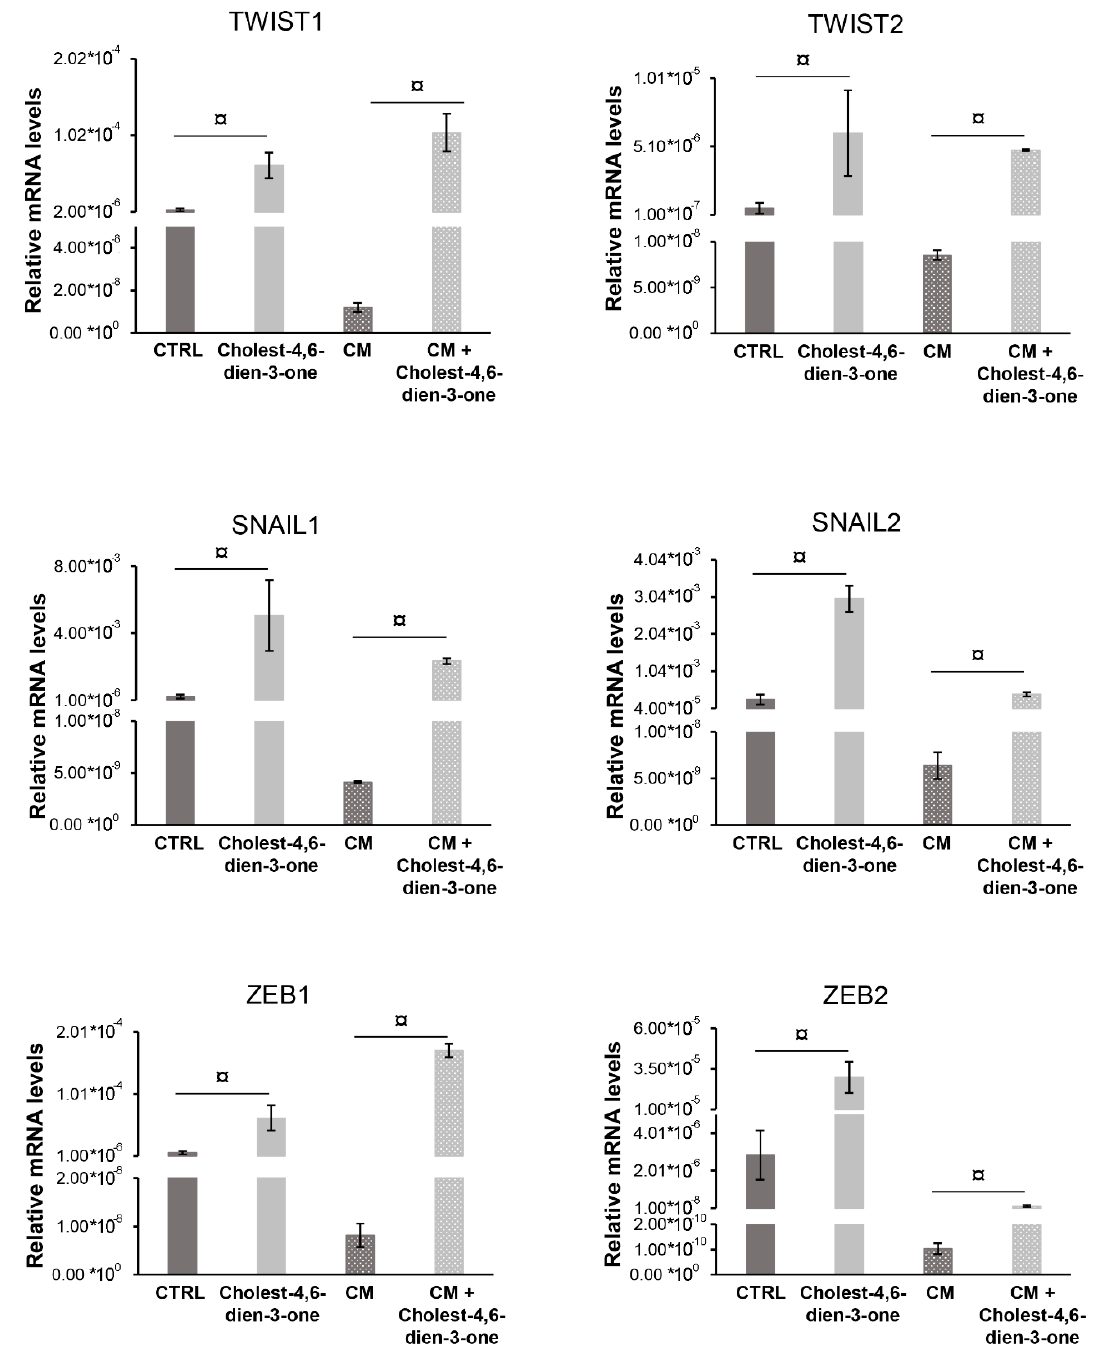
Figure 4. Cholest-4,6-dien-3-one enhanced the EMT markers analyzed by RT-qPCR. Relative gene expression of EMT markers ( TWIST1 , TWIST2 , SNAIL1 , SNAIL2 , ZEB1 , and ZEB2 ) examined by RT-qPCR of hBTSCs cultured in basal condition (KM), KM supplemented with cholest-4,6-dien-3-one, differentiation tailored cholangiocyte medium (CM) or CM added with cholest-4,6-dien-3-one. Data expressed as mean ± SD of N = 6 experiments; ¤ p < 0.0001.